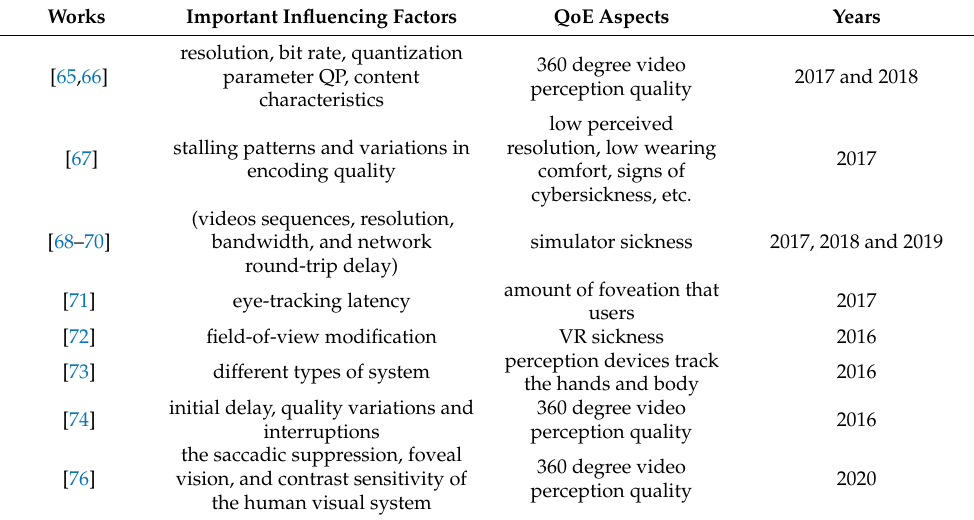
Table 3. Subjective quality assessment